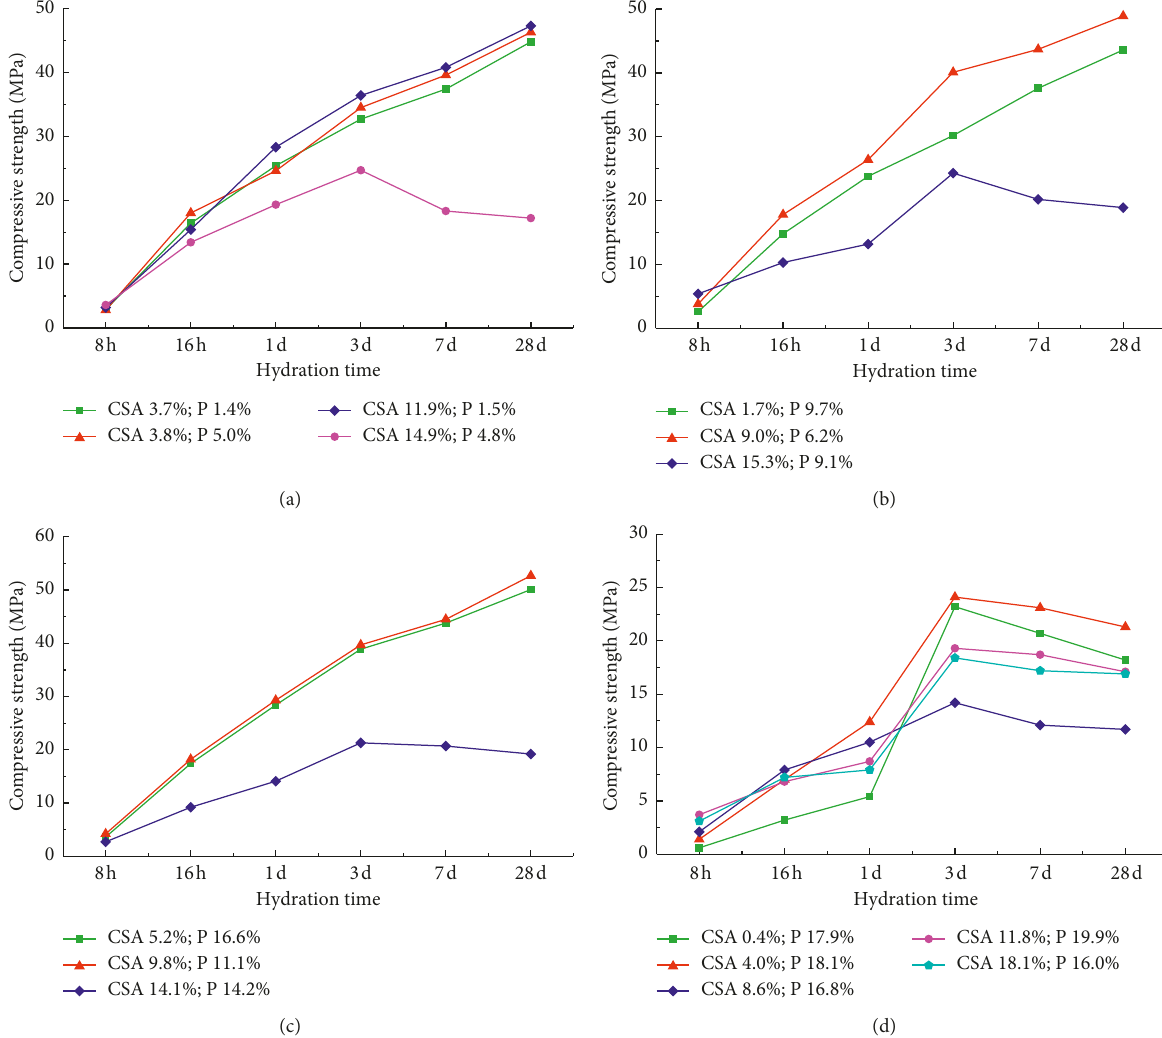
Figure 4: Trends of compressive strengths as a function of sample composition when the gypsum content is (a) 0–5%, (b) 5–10%, (c) 10–15%, and (d) 15–20%. CSA-sulphoaluminate cement;